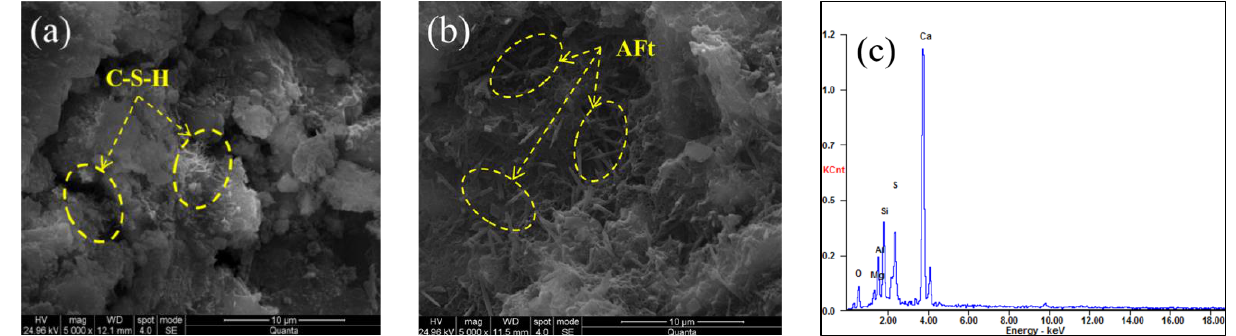
Figure 8. SEM patterns of FCG pastes for different FGD in 28 days: ( a ) FCG-1; ( b ) FCG-3; and ( c ) EDS of FCG-3.